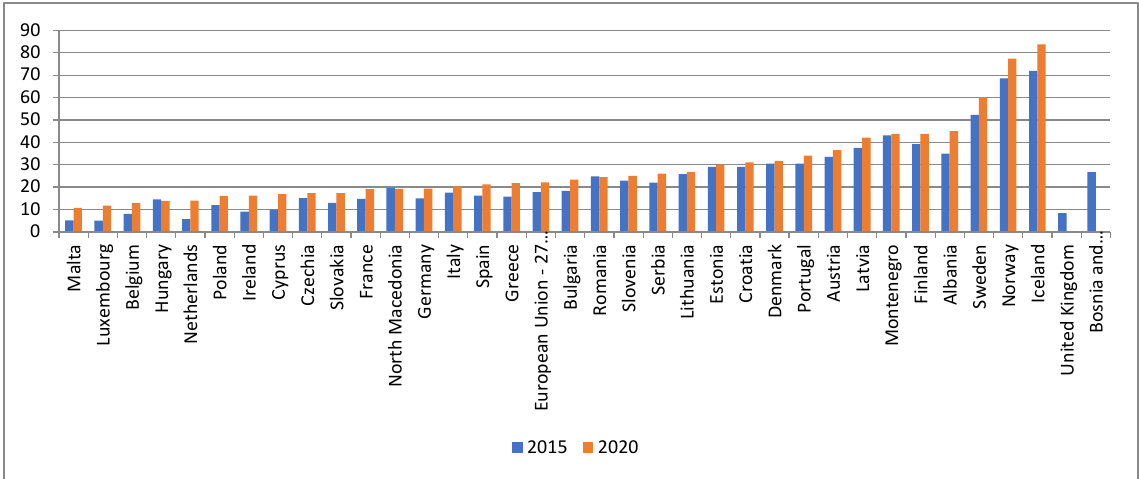
Figure 9. Share of renewable energy in the gross final energy consumption in European countries in 2015 and 2020 (in%). Source: own preparation based on the Eurostat database [47].